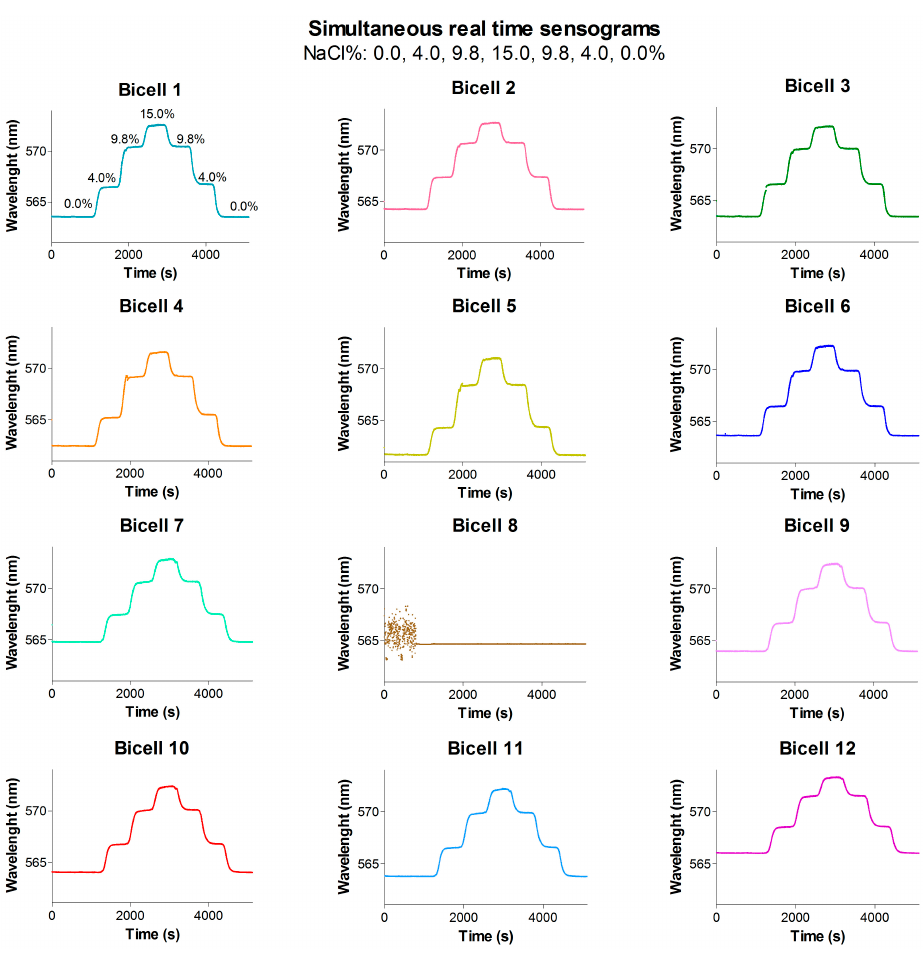
Figure 11. Sensograms (mn vs. time) of the 12 BICELLs acquired simultaneously under continuous flow conditions. Response to RI 1.3330, 1.3399, 1.3486 and 1.3565 (0.0–15.0% NaCl w/v). (BICELL 8 gives no signal due to the breakage of its illuminating optical fiber). Table 2. Reproducibility of BICELLs response within one chip (intra-chip, number of samples = 11 BICELLs) and among different chips (inter-chips, number of samples = 11 BICELLs × 20 sensor chips = 220). LoD or resolution was calculated according to Equation (1) where sample size n = 66 in all